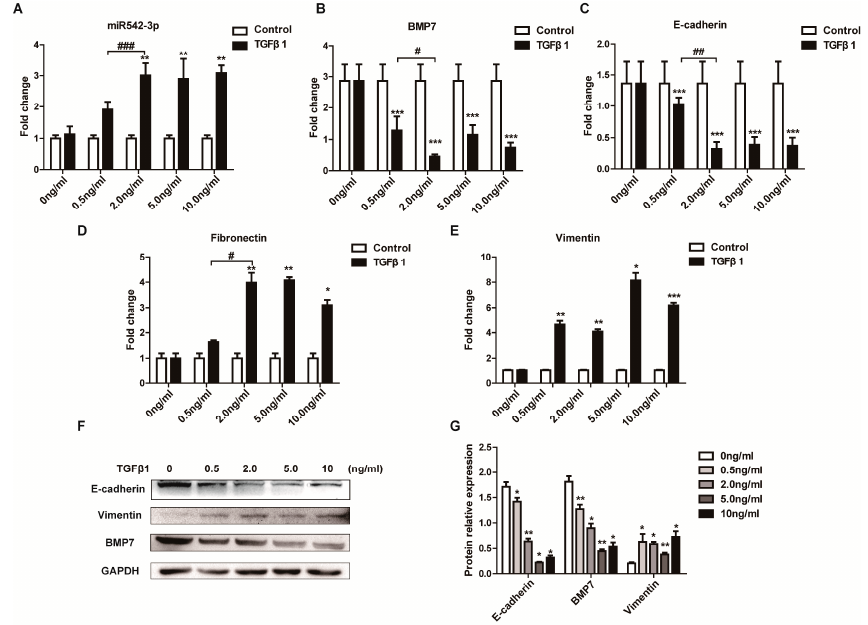
Figure 2. MiR542-3p expression regulated by TGF β 1. ( A ) miR542-3p expression elevated in the NRK52e cell line induced by different TGF β 1 concentration, the peaking concentration is 2 ng/mL; ( B – E ) The BMP7 and E-cadherin expressions were opposite to the expression of miR542-3p in the NRK52e cell line induced by different TGF β 1 concentrations. However the expression tendency of Fibronectin and Vimentin are just like that of miR542-3p in the NRK52e cell line induced by different TGF β 1 concentrations; ( F ) The expression level of BMP7, the epithelial marker, and the mesenchymal marker in NRK52e cells treated with different TGF β 1 concentrations; ( G ) Histogram shows the gray scale quantitative analysis for Western blot. All data are displayed as means ± SD from three independent experiments, * p < 0.05, ** p < 0.01, *** p < 0.001 versus NRK52e cells without being pre-treated by TGF β 1; # p < 0.05, ## p < 0.01, ### p < 0.001 versus NRK52e cells pre-treated by 0.5 ng/mL